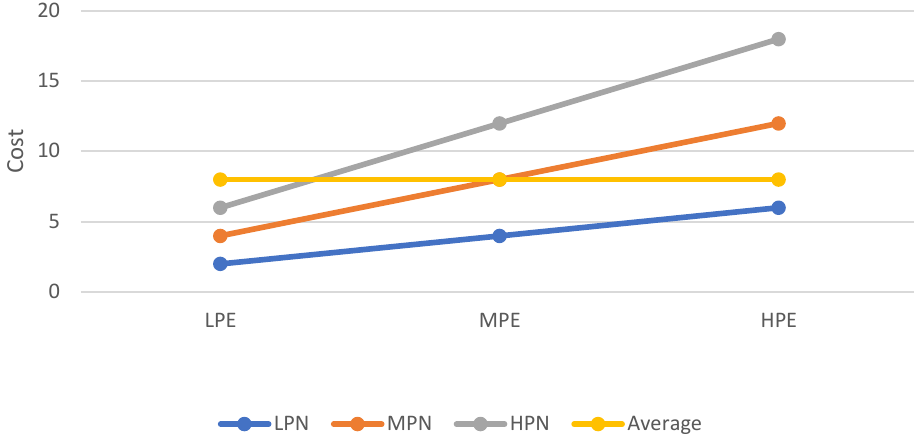
Figure 15. Comparing Solar Panels Cost .